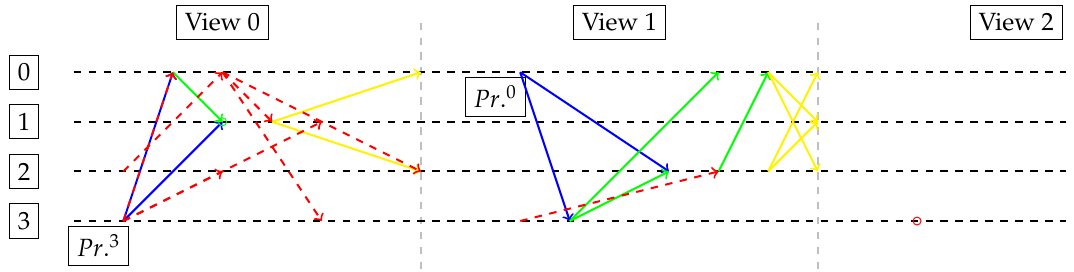
Figure 3. Scenario P3 with N = 4 and message reception Properties ( 3 ) and ( 4 ). Optimal value is 200, due to double views (no block is ever